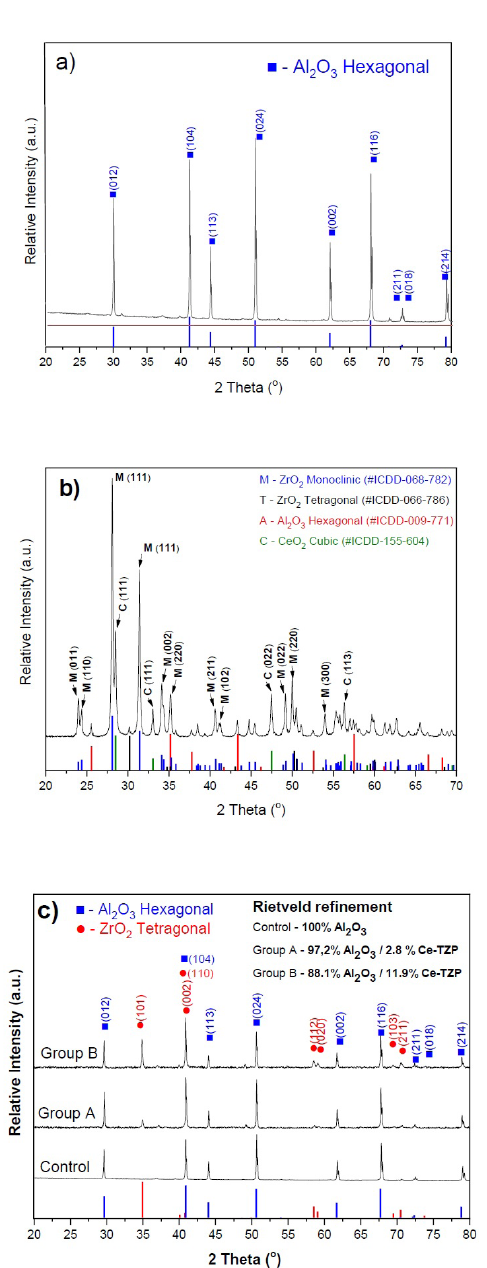
Figure 1. XRD patterns * of the starting powder and sintered samples: a)